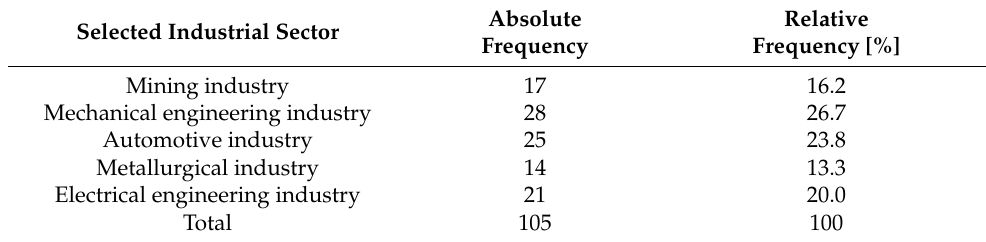
Table 4. Structure of the sample studied by industry